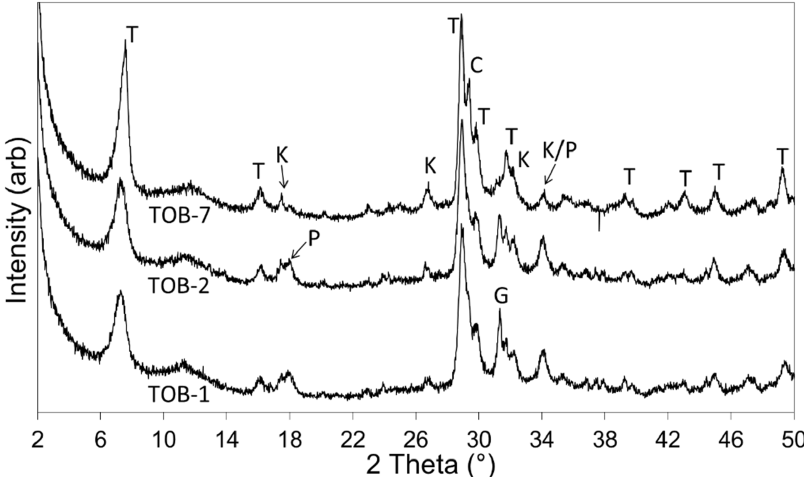
Figure 2. XRD patterns of 1-, 2-, and 7-day hydrothermal products (viz. TOB-1, TOB-2, and TOB-7) (Key: C = calcite; G = gehlenite; K = katoite; P = portlandite; T = Al-tobermorite).